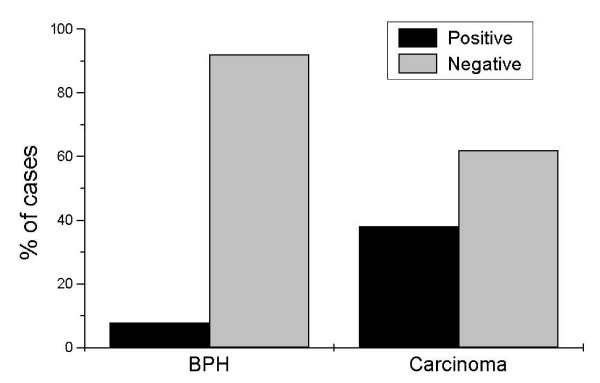
Distribution of positive and negative mARs in BPH and prostate carcinoma. Ninety % of benign prostate hyperplasia cases (n = 103) were negative for mAR receptor expression. On the other hand, prostate carcinoma cases (n = 106) showed mAR expression in a significant percentage (38% of these cases were positive) (χ2 = 16.7, p < 0.0001).